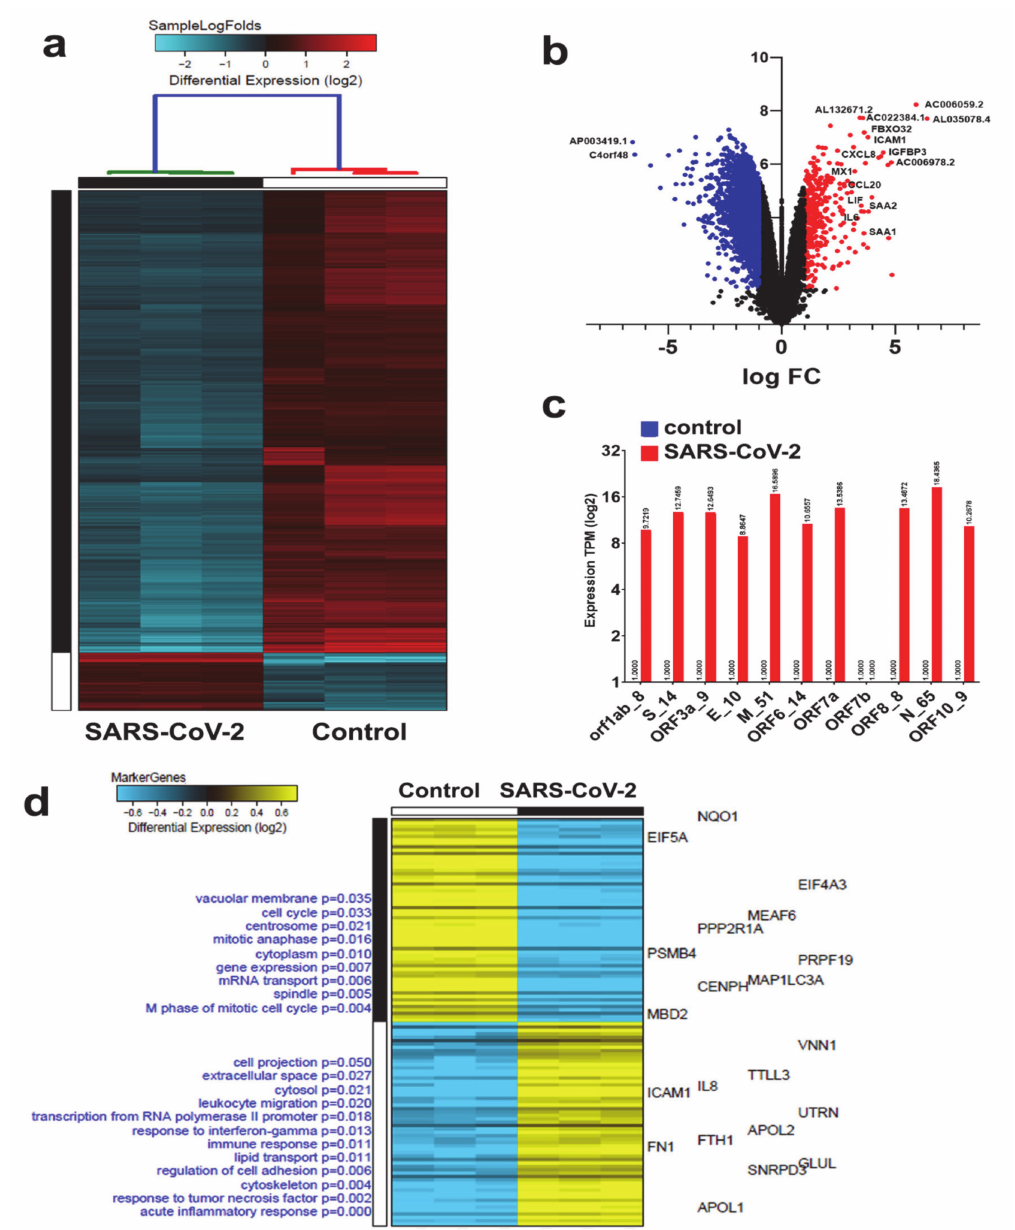
Figure 1. Clustering of SARS-CoV-2 and control NBHE cells based on mRNA RNA-seq analysis. ( a ) Hierarchical clustering of control and SARS-CoV-2 infected NHBE cells based on di ff erentially expressed mRNAs. Each column represents one replica, while each row represents one mRNA. Expression is depicted at the indicated color scales. ( b ) Volcano plot representation of significantly altered genes in NHBE SARS-CoV-2 vs. mock infected cells. Red and blue colors indicate the genes with significantly increased or decreased expression, respectively. ( c ) Relative expression of the indicated viral genes in SARS-COV-2 NHBE vs. control NHBE cells. ( d ) Marker discovery analysis to identify putative markers that are selectively expressed in control vs. SARS-CoV-2 infected NBHE cells. Enriched gene ontology (GO) associations are indicated on the y